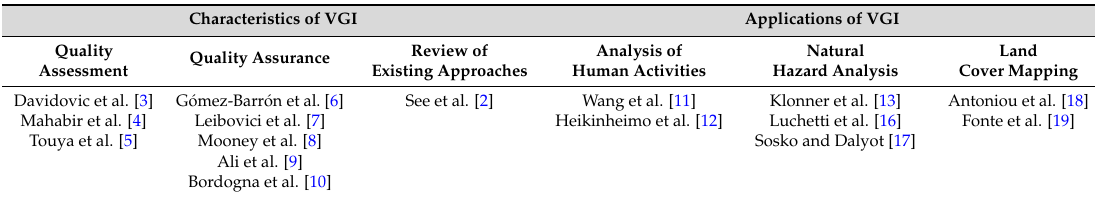
Table 1. Main themes of the papers in the Special